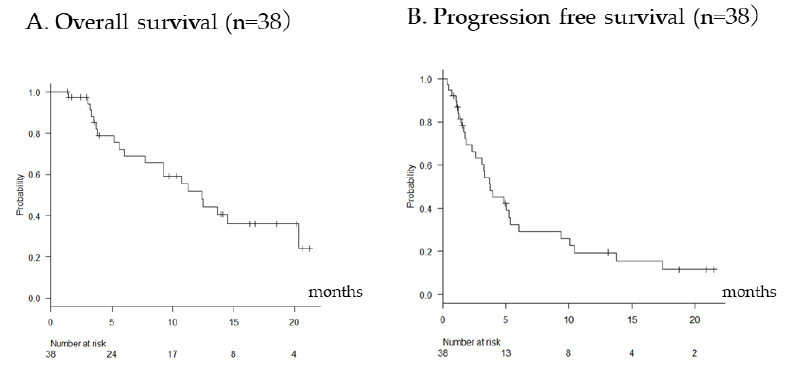
Figure 1. Overall survival ( A ) and progression-free survival ( B ) in all patients.